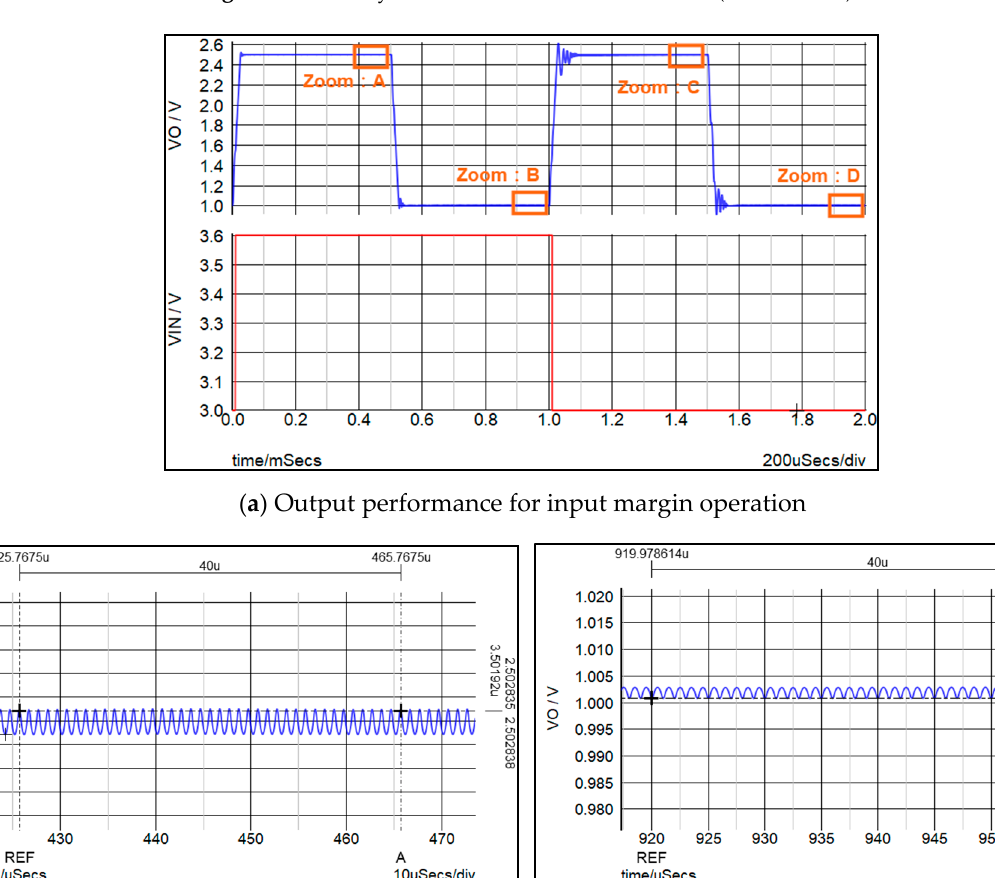
Figure 9. Recovery times for load current transition (100 – 500 mA).